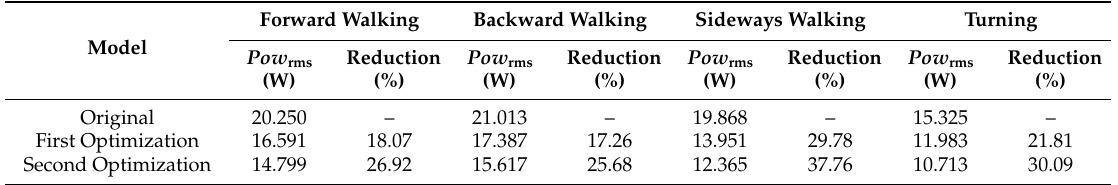
Table 6. Root-mean-square (RMS) power reduction using an optimized model in humanoid hip joints during target